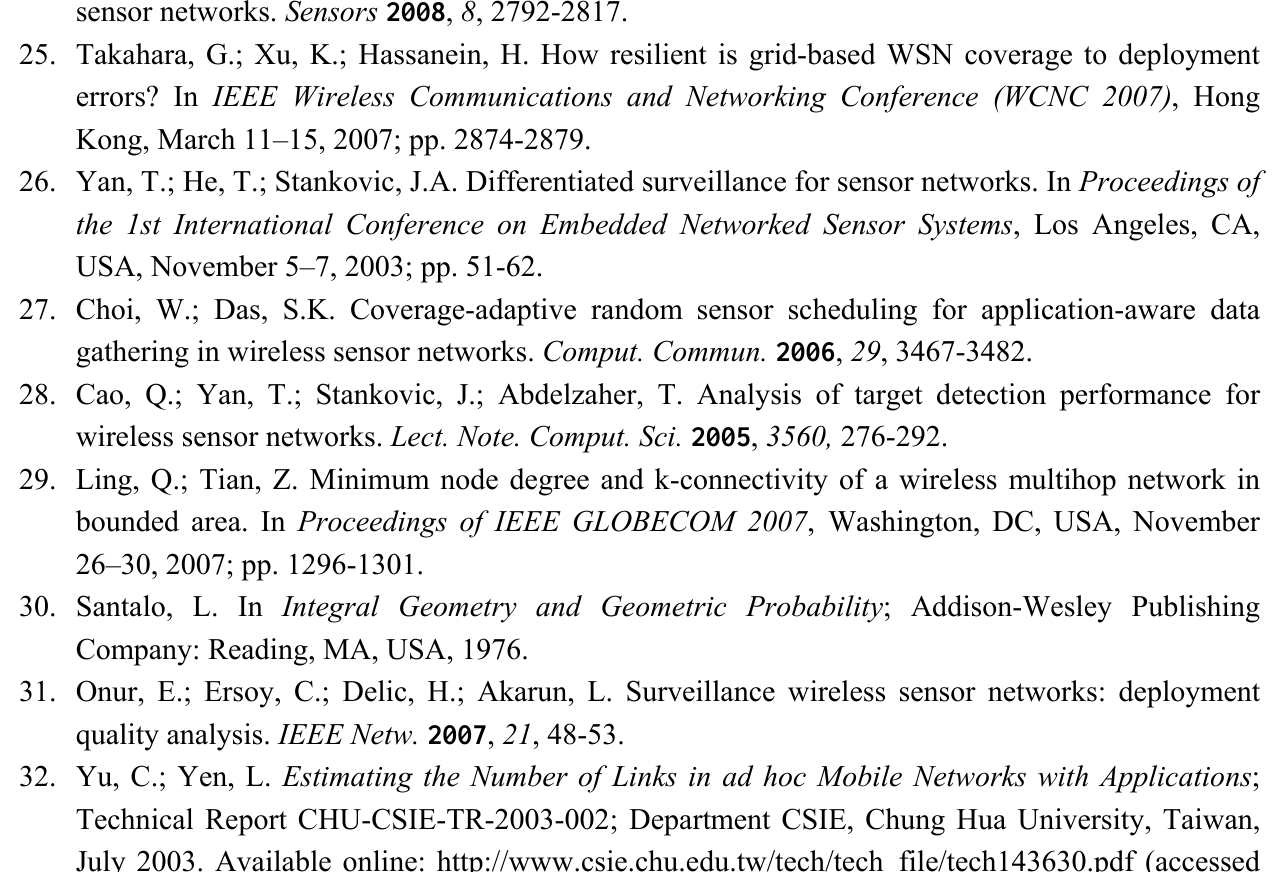
Figure 13. A sensor node located in sub-region Ω